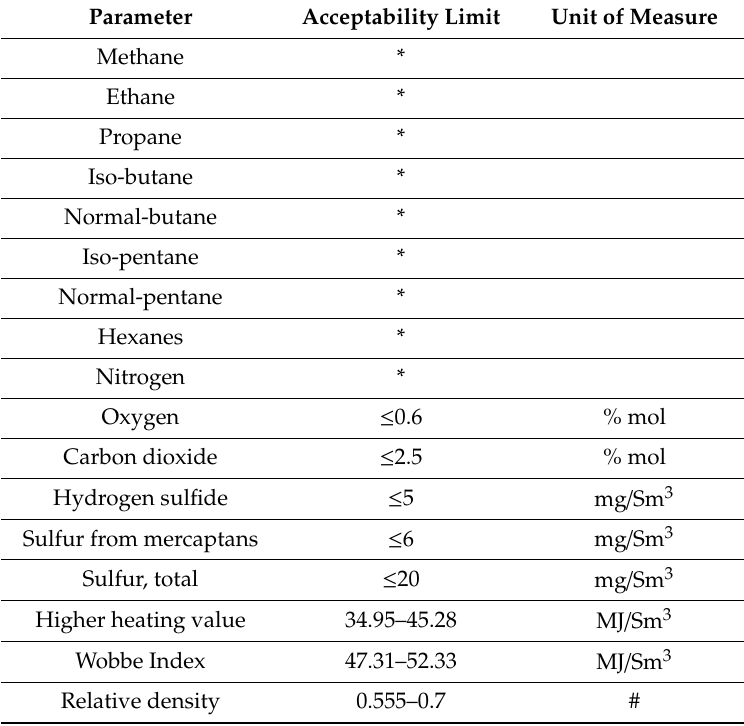
Table 2. Mean natural gas composition conveyed by the Italian natural gas networks [43].